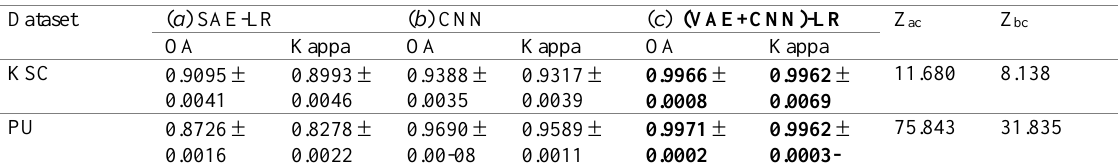
Table 3. Classification performance comparison using kappa coefficient and